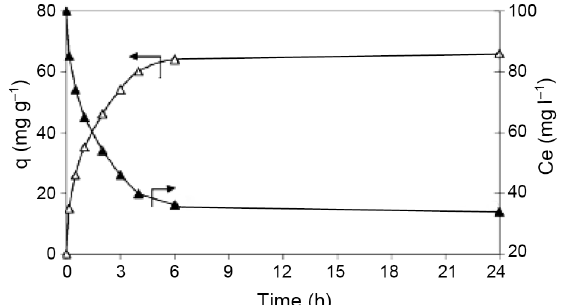
Fig. 1. Variation of solid phase (biosorbed) and aqueous phase nickel ion concentrations with